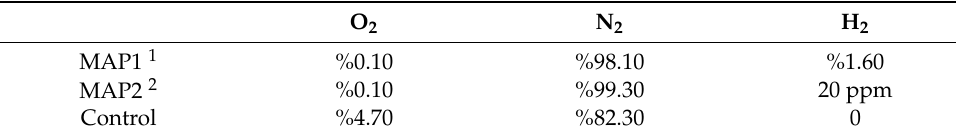
Table 2. Gas rates in sample packs after 28 days.